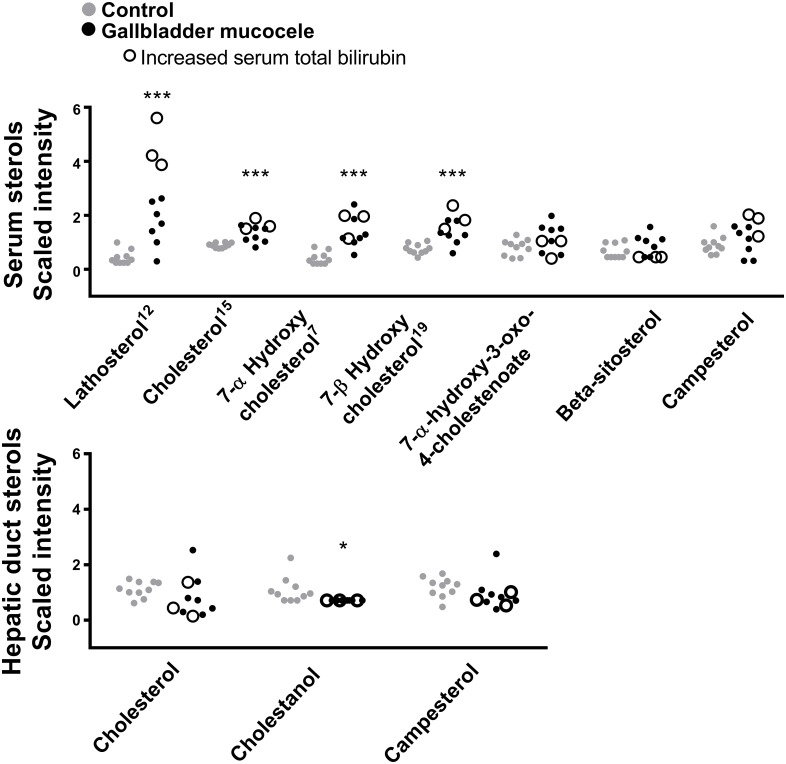
Compounds related to cholesterol metabolism identified in the serum (top panel) and hepatic duct bile (bottom panel) of dogs with gallbladder mucocele formation compared to control dogs.Data points represent individual dogs. Dogs with mucocele formation and a concurrent increase in serum total bilirubin are designated with open circles. Superscript numbers, when present, indicate rank of the compound as identified by Random Forest analysis as able to distinguish between control dogs and dogs with gallbladder mucocele formation. *p<0.05, ***p<0.001 Welch’s two sample t-test.